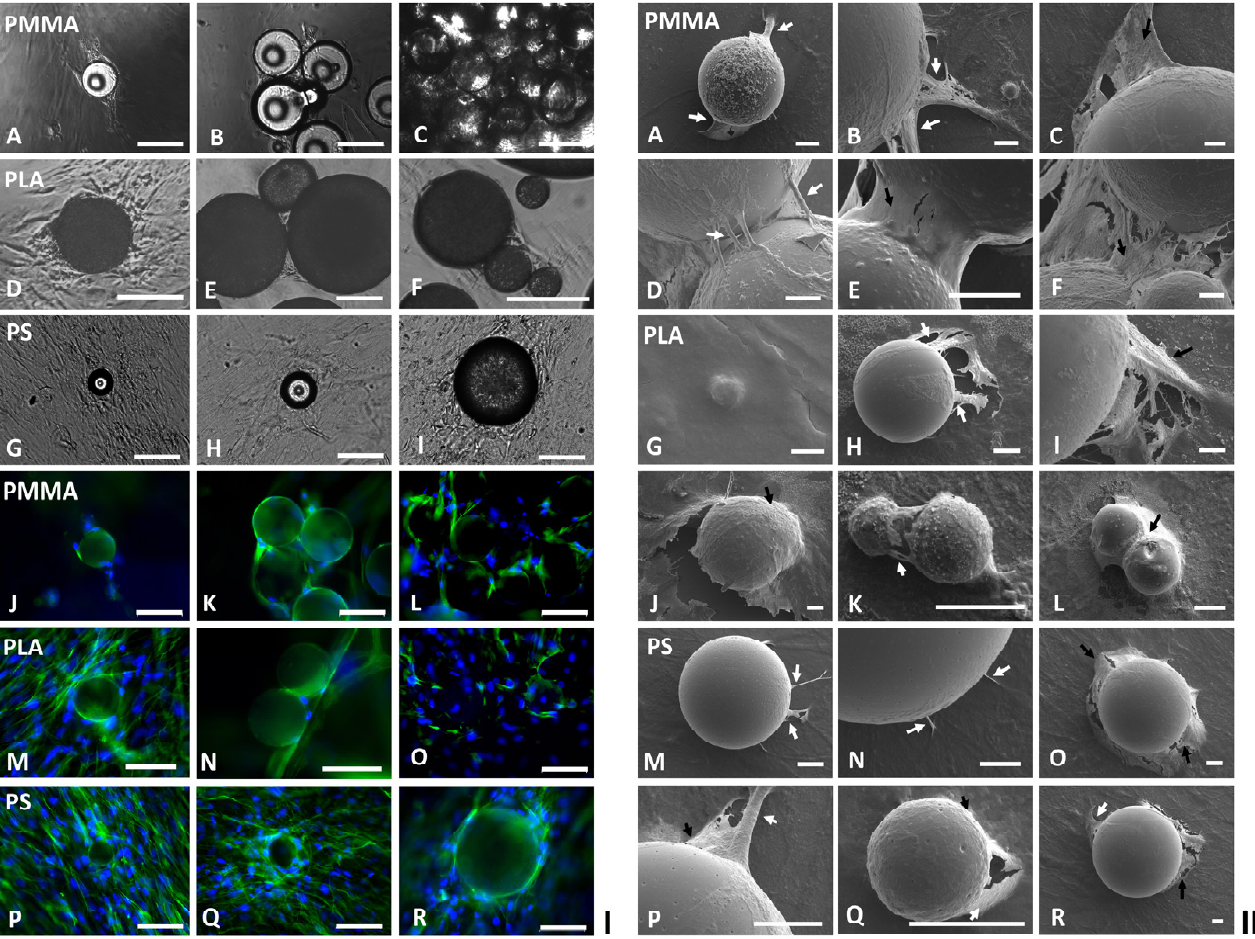
Figure 1. ( I , II ) Micrographs of human dermal fibroblasts (HDFs) cultured on spherical modular scaffolds. Aliquots of 1 mL HDFs (10 3 cells/mL) were seeded in each well of 24-well tissue culture plate containing 5 mg poly(methyl methacrylate) (PMMA), poly(lactic acid) (PLA) or polystyrene (PS) particles (diameter: 5, 10, 20, 30 or 100 µ m) submerged in 1 mL DMEM and cultured for 14–30 days. The phase contrast micrographs of HDFs ( I ) cultured on ( A – C ) PMMA, ( D – F ) PLA and ( G – I ) PS particles; the fluorescent micrographs of HDFs ( I ) cultured on ( J – L ) PMMA, ( M – O ) PLA and ( P – R ) PS particles were captured. Blue: nuclei stained by DAPI, Green: cytoskeleton stained by phalloidin. (scale bar = 100 µ m). Scanning electron micrographs of HDFs ( II ) cultured on ( A – F ) PMMA, ( G – L ) PLA and ( M – R ) PS particles were captured. Cell colonization strategies via cell bridging and cell stacking are highlighted via White and Black arrows respectively. (scale bar = 10 µm except G = 1 µm).